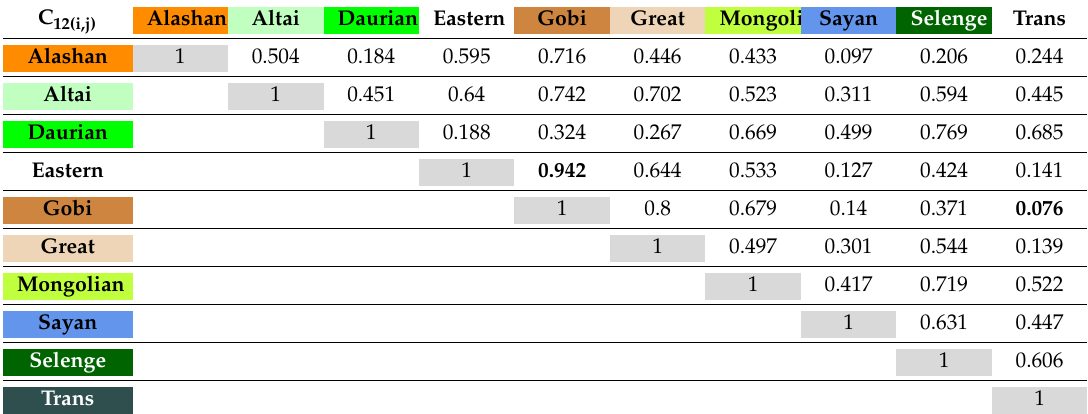
Table 2. Pairwise estimates of similarity between ecoregions with online tool Spade [69]. Shown is the estimatedabundance-basedSorensenIndex. ColorsrefertothemapinFigure1. Ecoregionabbreviations as in Figure 4. Highest and lowest values in bold.